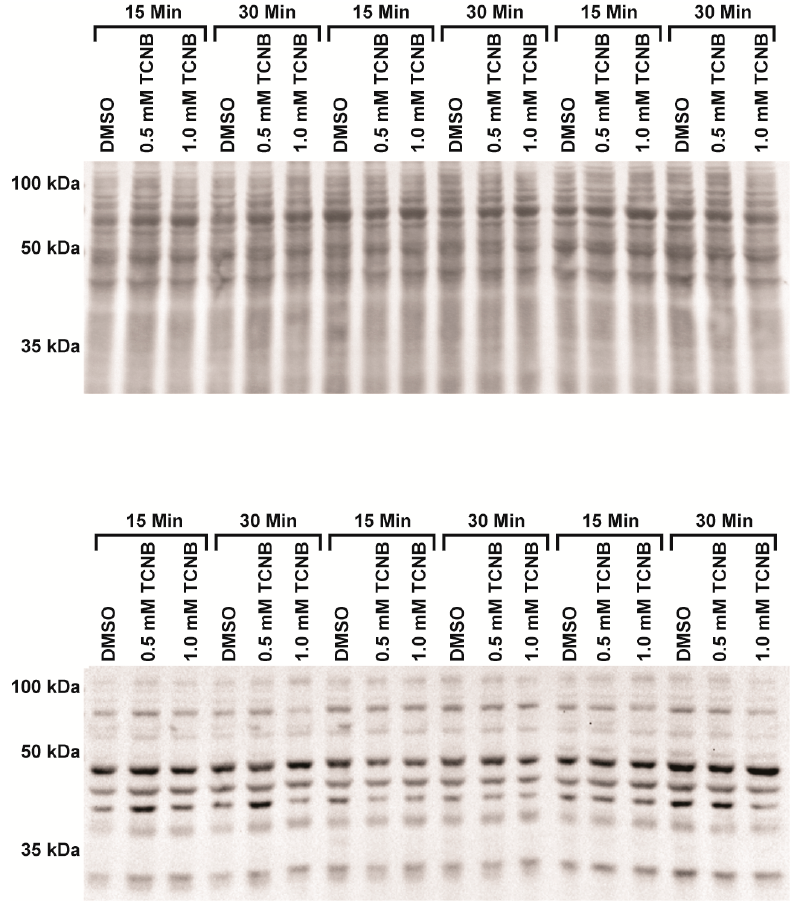
Figure 6. Effect of 3,4,5-TCNB treatment on 4-HNE adduction in IRCC from three different animals. The top panel represents the total protein, while the bottom panel represents the 4-HNE adducted proteins. n = 3 separate experiments.